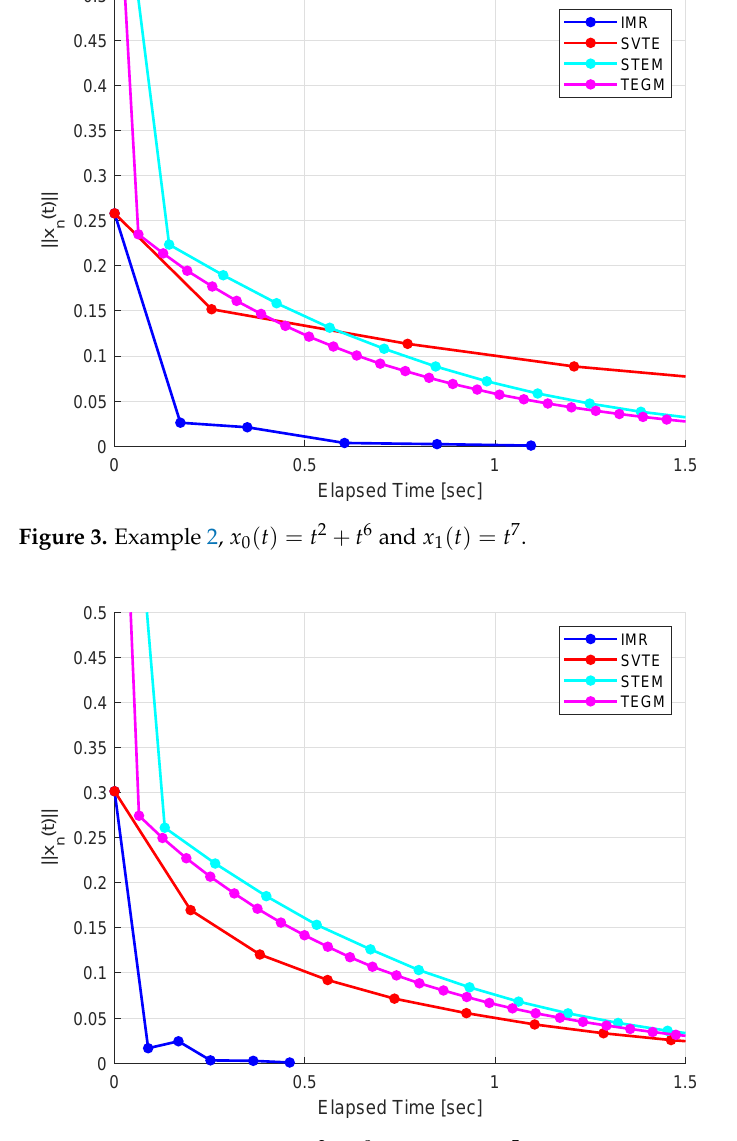
Figure 4. Example 2, x 0 ( t ) = t 2 + t 8 and x 1 ( t ) = t 5